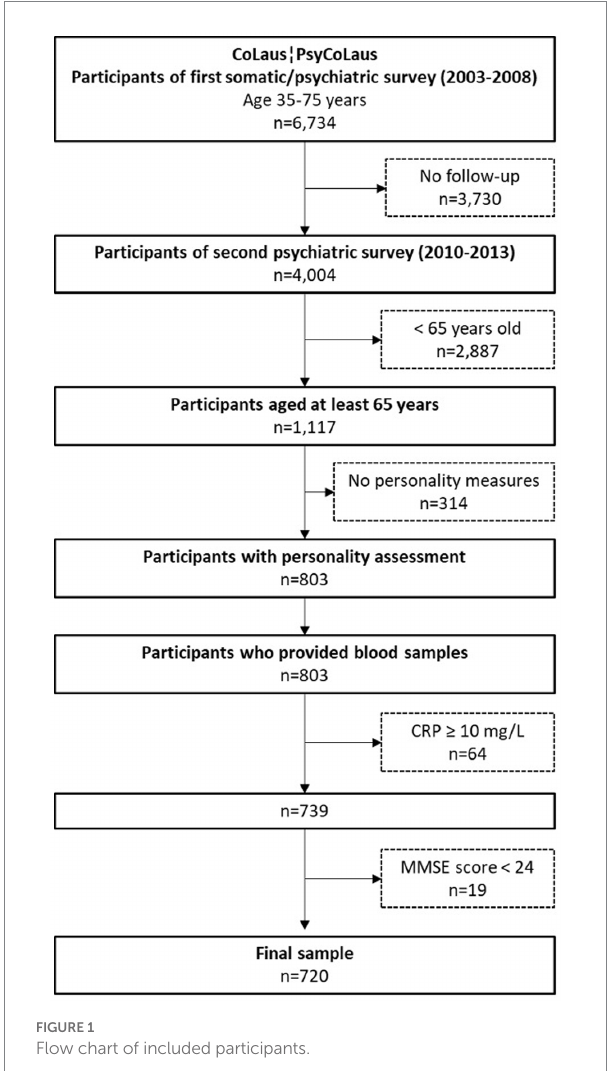
FIGURE 1 Flow chart of included